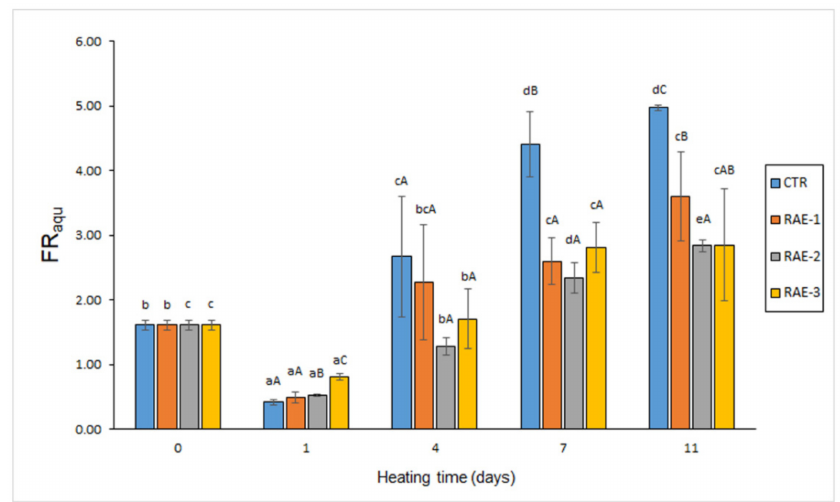
Figure 2. The evolution of fluorescent compound content in the aqueous extract obtained from the lipid extraction of fish muscle (FR aqu ) heated in the presence of red alga extract (RAE). Abbreviations of RAE concentrations are as expressed in Table 1. Mean values of three independent determinations ( n = 3); standard deviations are shown by bars. Mean values accompanied by lowercase (a–e) letters denote significant differences ( p < 0.05) as a result of heating time; mean values accompanied by capital letters (A–C) denote significant differences ( p < 0.05) as a result of RAE concentration.